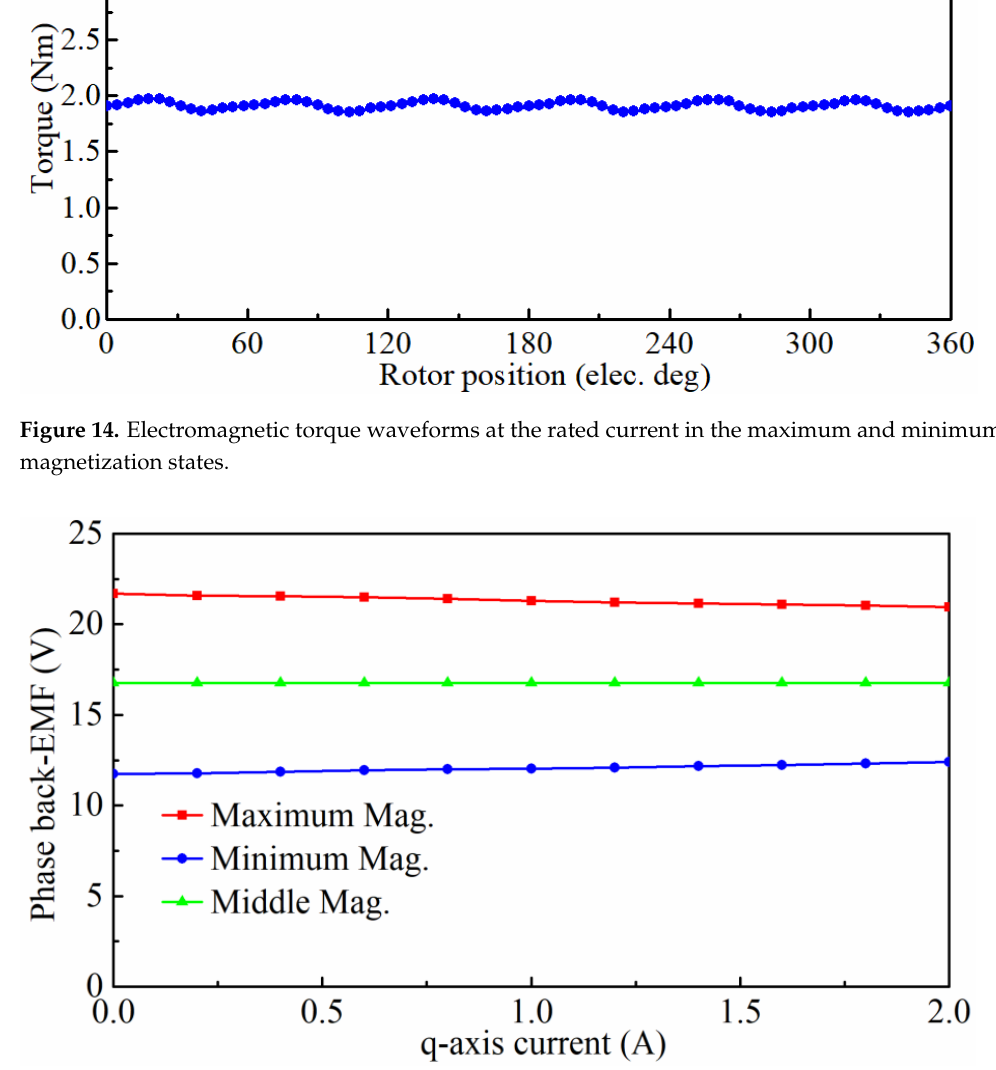
Figure 15. Back-EMFs after different load currents.